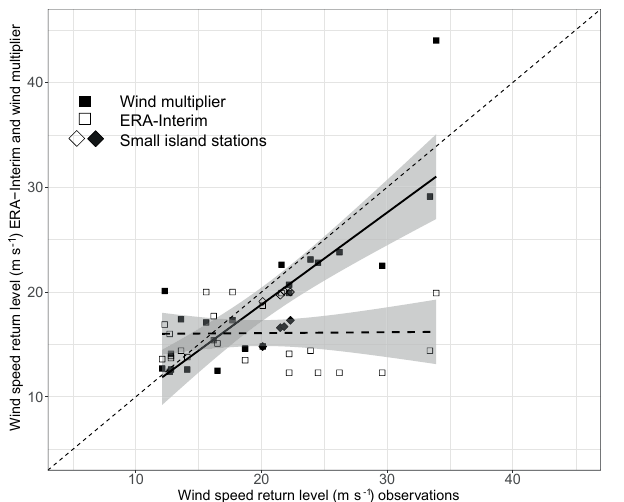
Figure 6. Comparison of 10-year return levels of maximum wind speeds, as calculated, based on observations and by utilizing the wind multiplier method (Eq. 1) and the ERA-Interim dataset for the 26 measuring sites (Fig. 5). Return levels taken directly from the ERA-Interim dataset with no wind multiplier correction are in- cluded in the visualization. The shaded areas are 95% confidence levels for the linear trend lines depicting the dependence between the datasets. The diamond shape symbols indicate that the station is located on small Baltic Sea